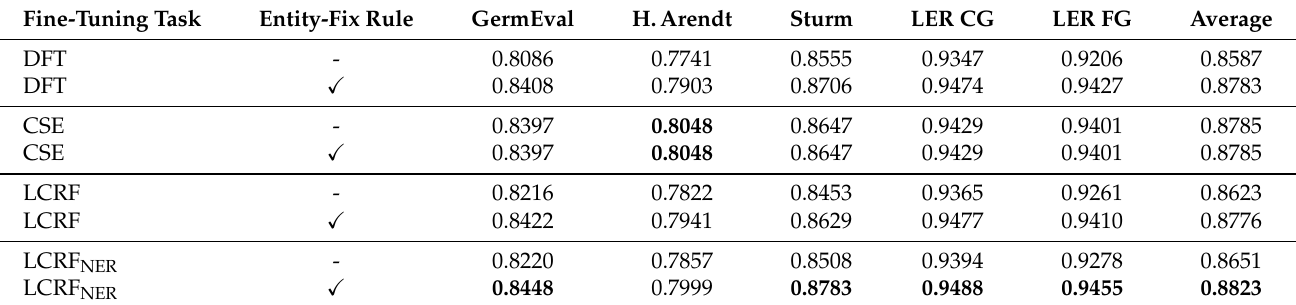
Table 8. Average E- F 1 score of three fine-tuning runs on BERTs pre-trained with Mask Language Model (MLM), relative positional encoding, and Whole-Word Masking (WWM). Rows refer to the fine-tuning methods Default-Fine-Tuning (DFT), Class-Start-End (CSE), Linear Chain Conditional Random Field (LCRF), and LCRF NER ; Columns refer to the NER task; best results per column are